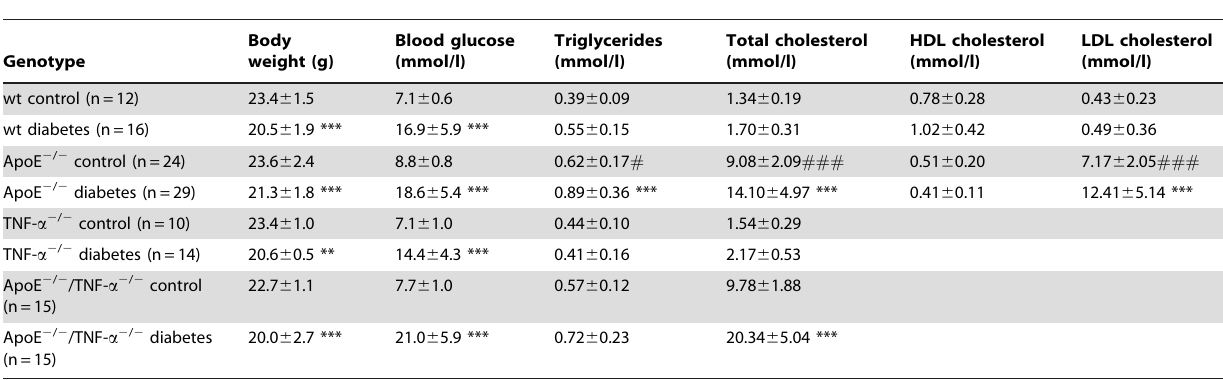
Table 1. Body weight, blood glucose, triglycerides, total cholesterol, LDL and HDL in control and diabetic mice of different genotypes (experimental set